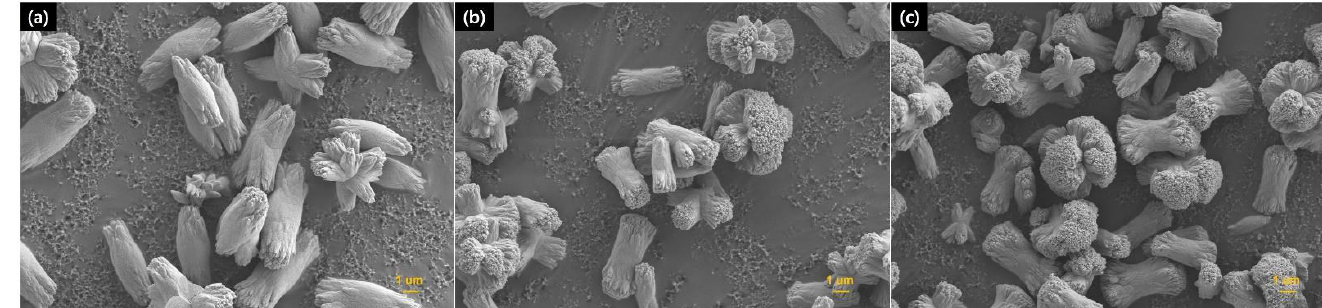
Figure 3. FE-SEM images of ( a ) SrWO 4 , ( b ) SrWO 4 :Tb 3+ , and ( c ) SrWO 4 :Eu 3+ samples.